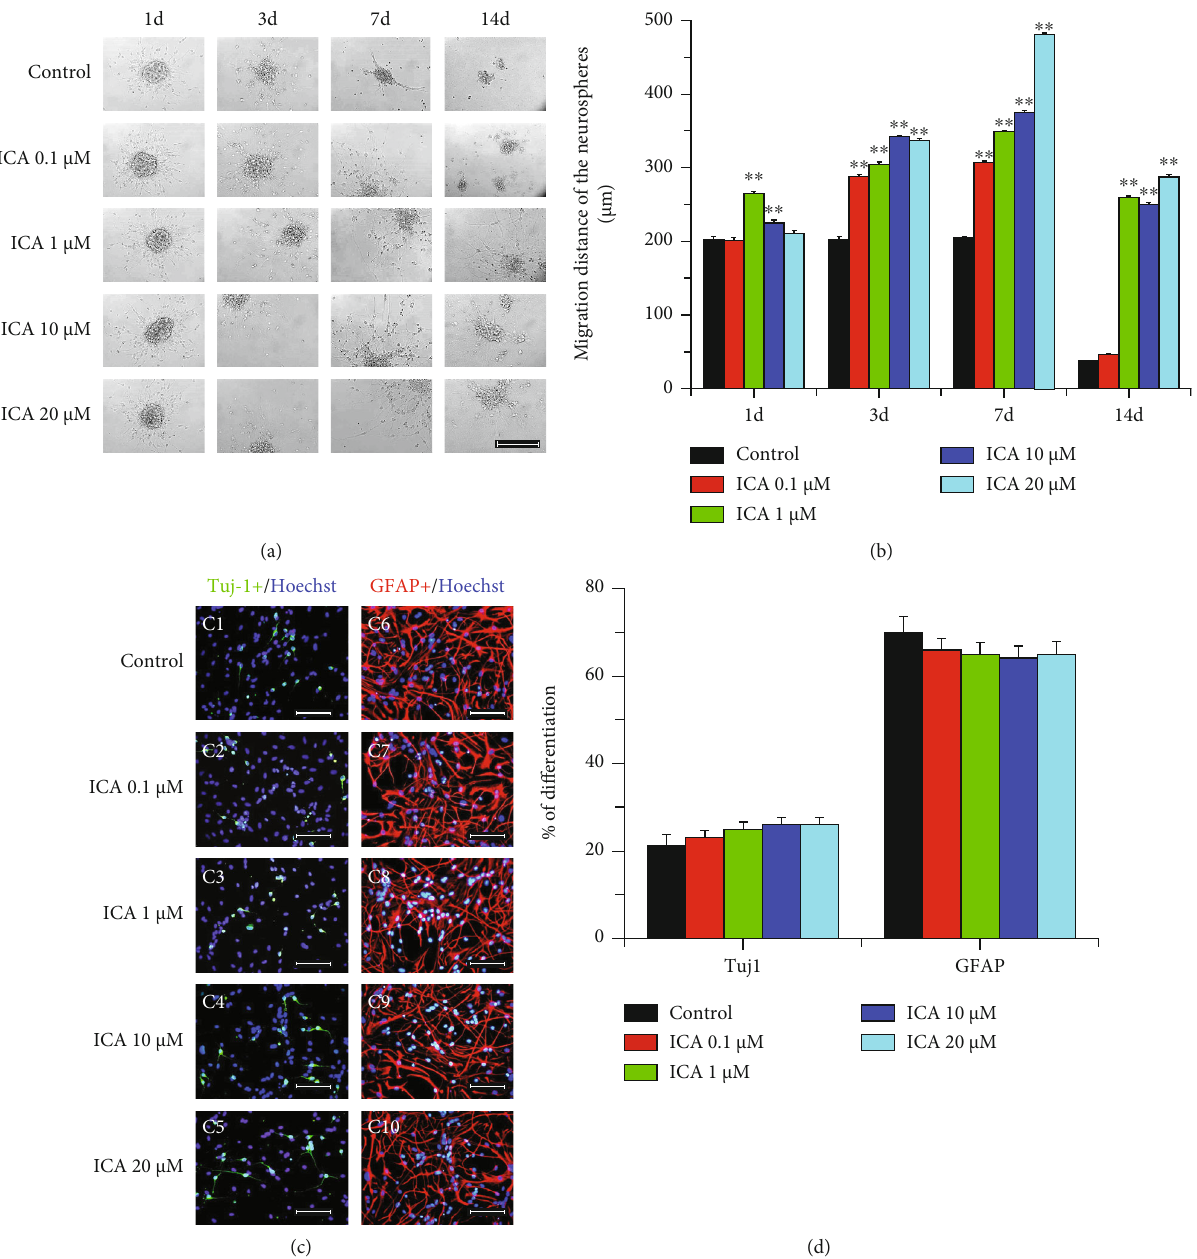
Figure 3: ICA promoted the migration ability and di ff erentiation of NSCs in vitro . (a) Representative images of individual NSCs migrated from the neurospheres incubated in B27 medium without bFGF and EGF at 1, 3, 7, and 14 days. Scale bar = 200 μ m . (b) Quantitative analysis of the migration distance of the neurospheres at di ff erent time points after ICA incubation. Data are expressed as the mean ± SEM , n = 10 . (c) Immunostaining of Tuj1 or GFAP to determine the e ff ect of ICA on the di ff erentiation of NSCs after seven days of incubation. Scale bar = 100 μ m . (d) Quantitative analysis of the percentage of Tuj1 or GFAP-positive cells to Hoechst-labeled NSCs. Data are expressed as the mean ± SEM , n = 25 . ∗∗ P < 0 : 01 , drug-treated groups vs the control